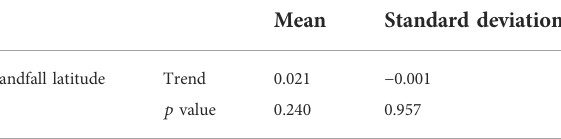
TABLE 2 Thesameas Table 1,butfor the mean andstandard deviation oflandfalllatitudeofTCsovermainlandChinafrom1980to2020.